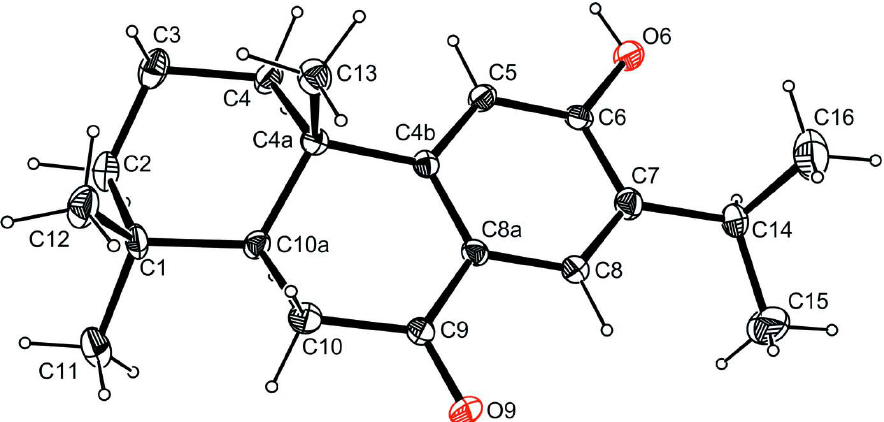
Figure 1 Molecular view of the title compound with the atom-labelling scheme. Displacement ellipsoids are drawn at the 30% probability level. H atoms are represented as small spheres of arbitrary